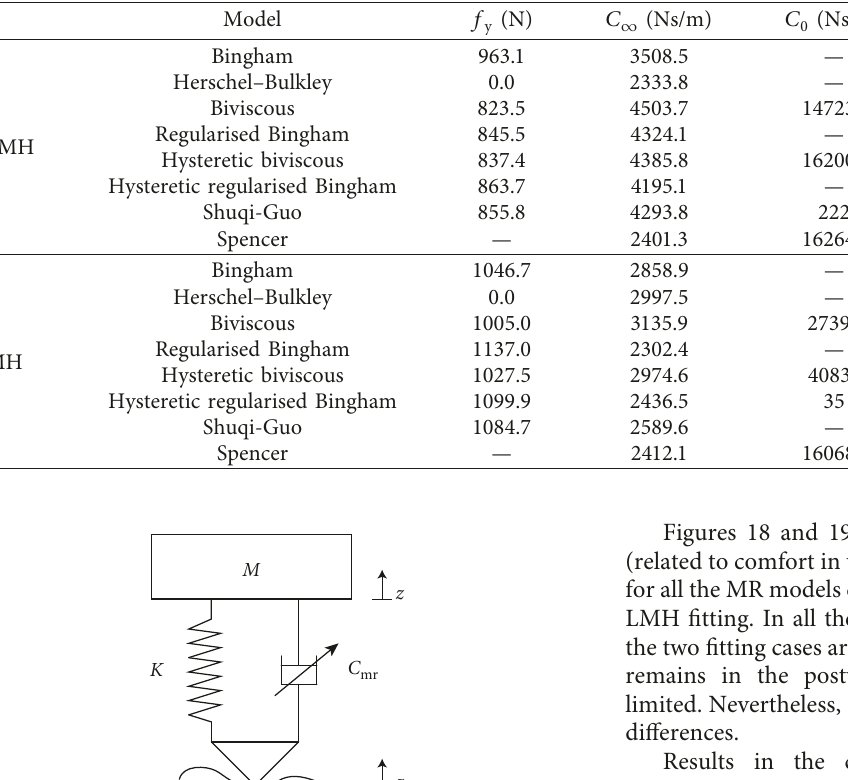
Table 2: Model parameters after fitting with I � 1A.